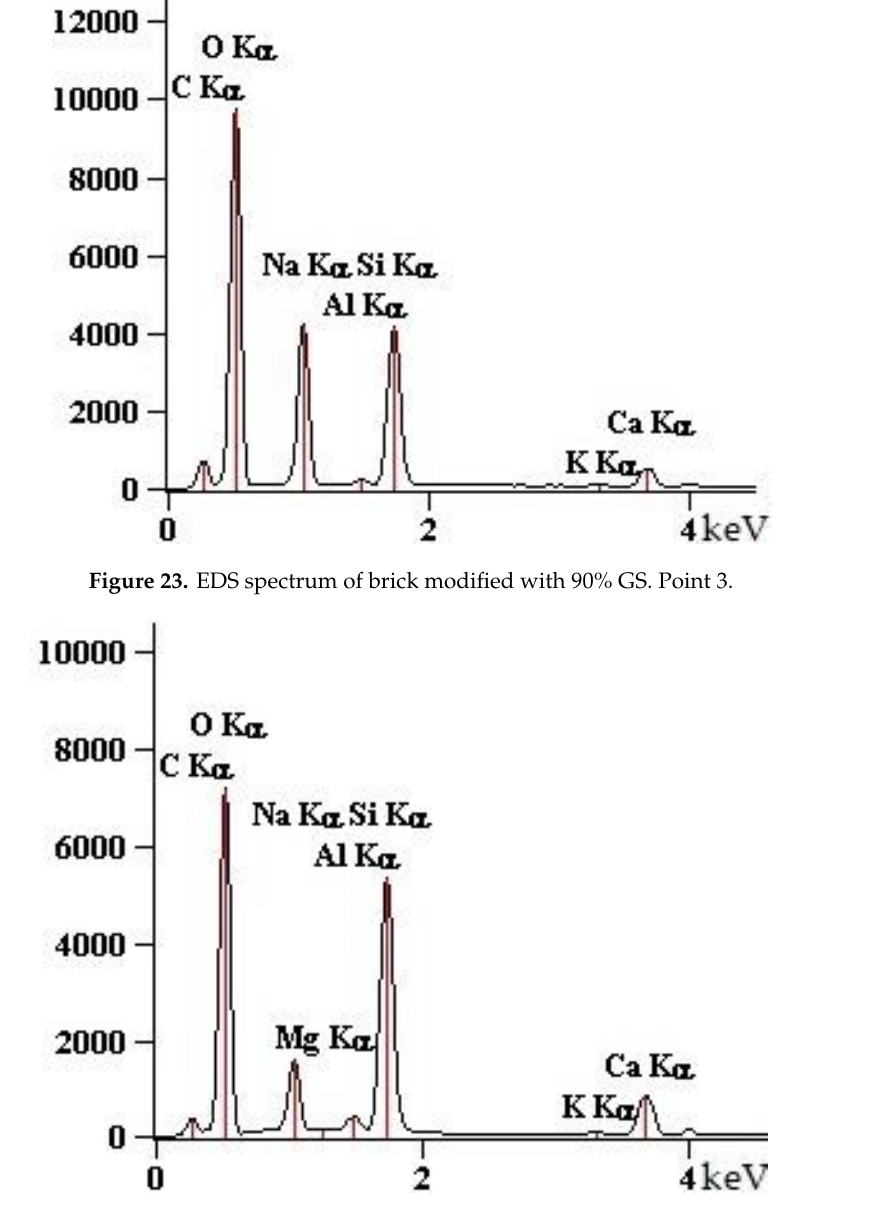
Figure 24. EDS spectrum of brick modified with 90% GS. Point 4. Table 1. EDS analysis results for a ‘new’ brick with 90% GS.